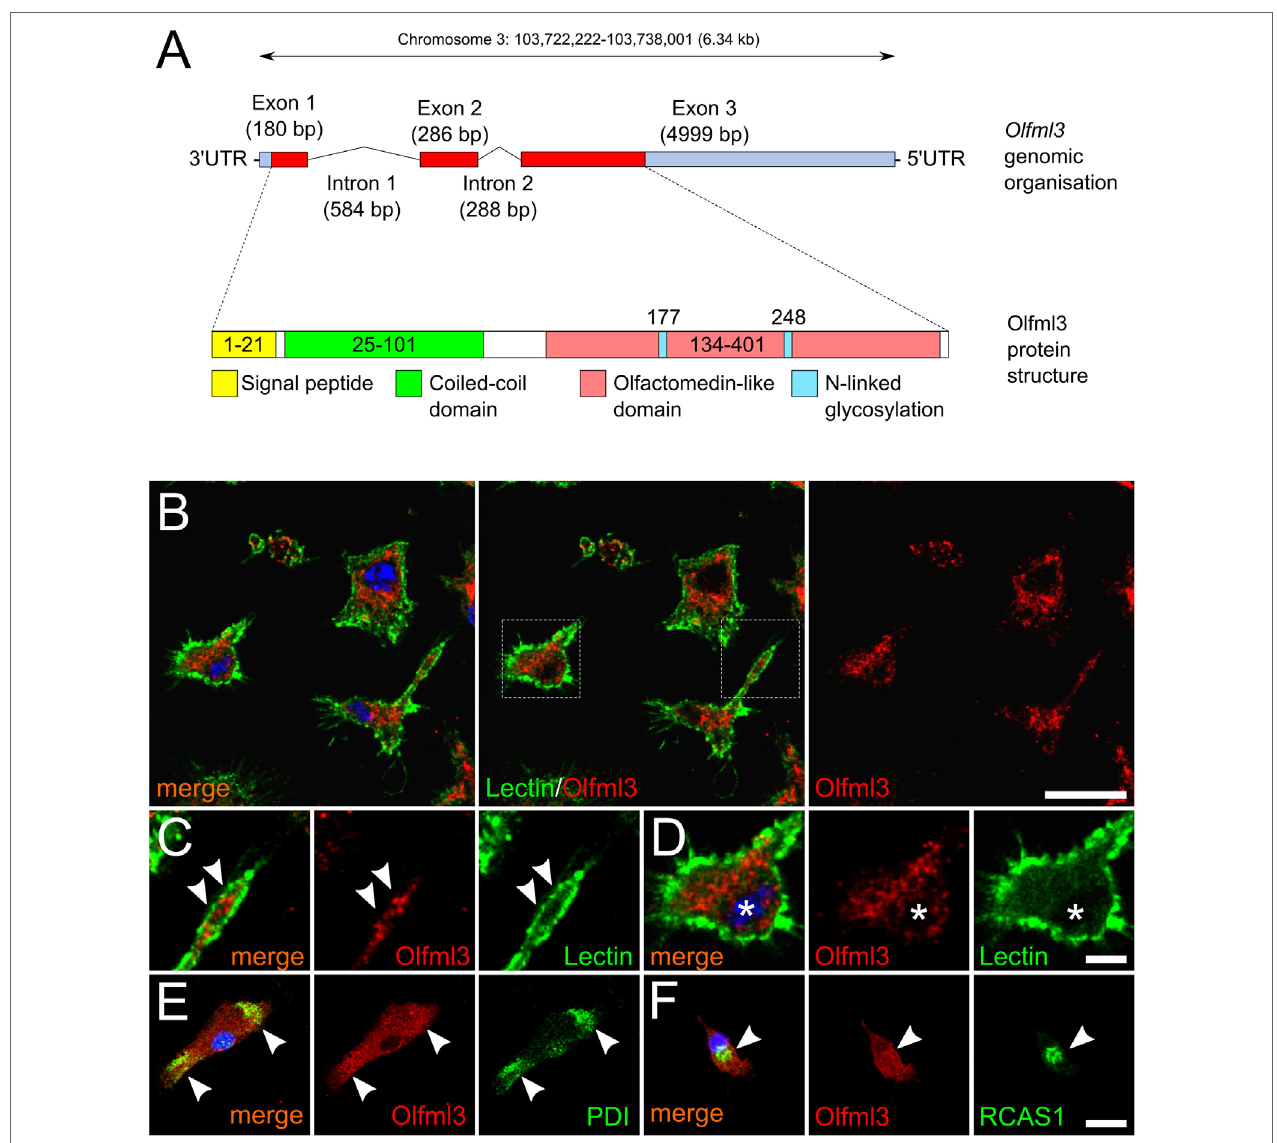
FigUre 1 | Cytoplasmic localization of Olfml3 in primary microglia. (a) Schematic genomic organization and protein structure of Olfml3. (B) Immunofluorescence demonstrating the cellular localization of Olfml3 in primary microglia. FITC-coupled tomatolectin was used to label cell membranes. Nuclei were counterstained using DAPI. Dashed rectangles mark areas depicted in panels (c,D) . Scale bar indicates 10 µm. (c) White arrowheads mark Olfml3 located in microglial processes. (D) Olfml3 immunoreactivity in the perinuclear cytoplasm. Asterisks mark the nucleus. Scale bar represents 5 µm. (e) Colocalization of Olfml3 with the endoplasmic reticulum (ER) marker protein disulfide isomerase (PDI). White arrowheads mark Olfml3 located in the ER. (F) Colocalization of Olfml3 with the Golgi marker RCAS1. White arrowheads mark Olfml3 located in the Golgi apparatus. Scale bar indicates 10